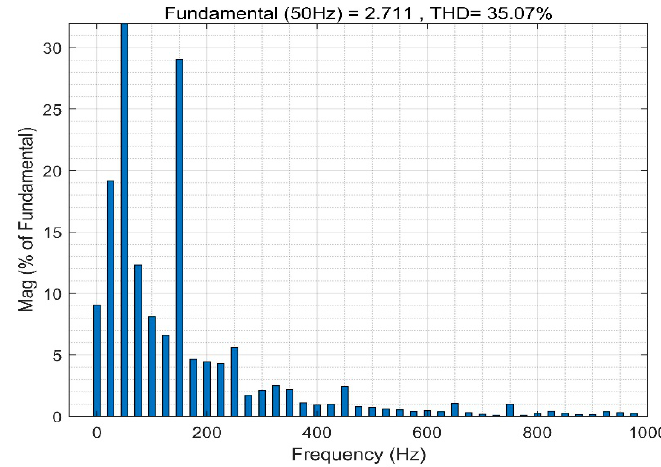
Figure 6. Harmonic spectrum of power supply current before compensation.